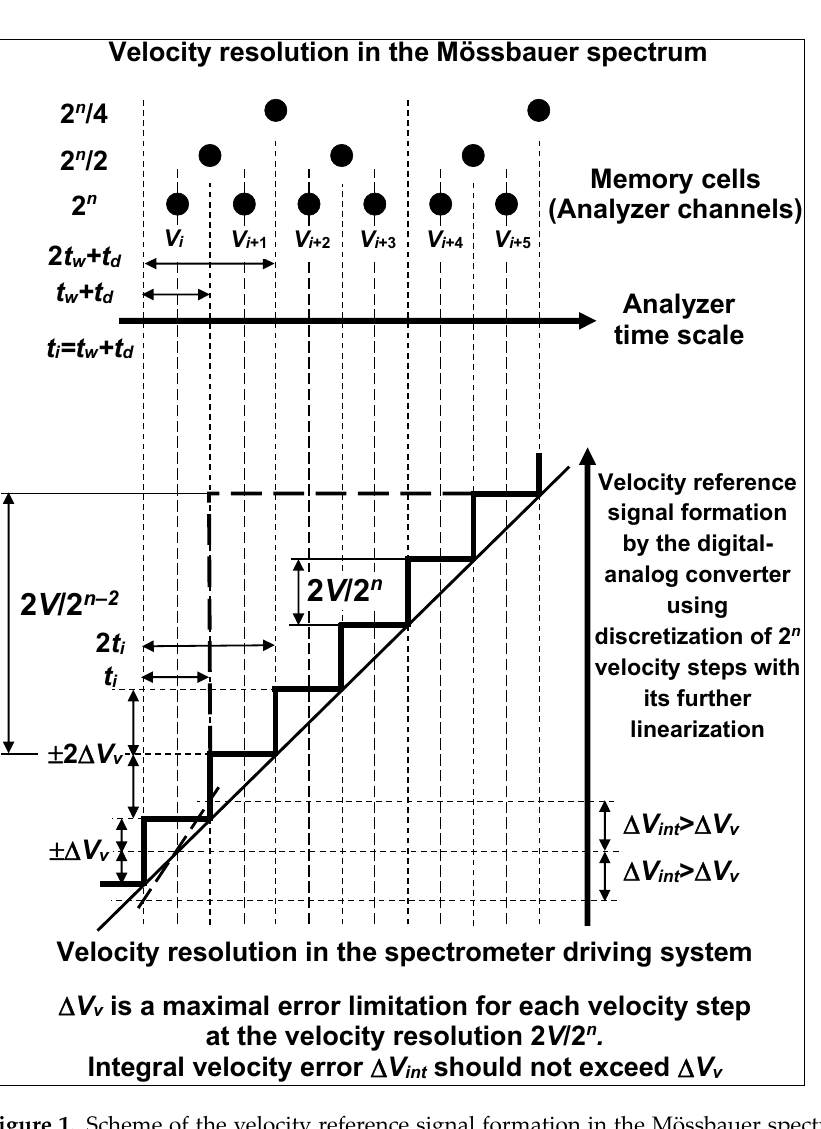
Figure 1. Scheme of the velocity reference signal formation in the Mössbauer spectrometer and in the spectrum. Adapted from Ref. [31]. (Reproduced from “Mössbauer spectroscopy with a high velocity resolution: Principles and applications”, M.I. Oshtrakh and V.A. Semionkin; AIP Conference Proceedings 1781 , 020019 (2016), with the permission of AIP Publishing.)